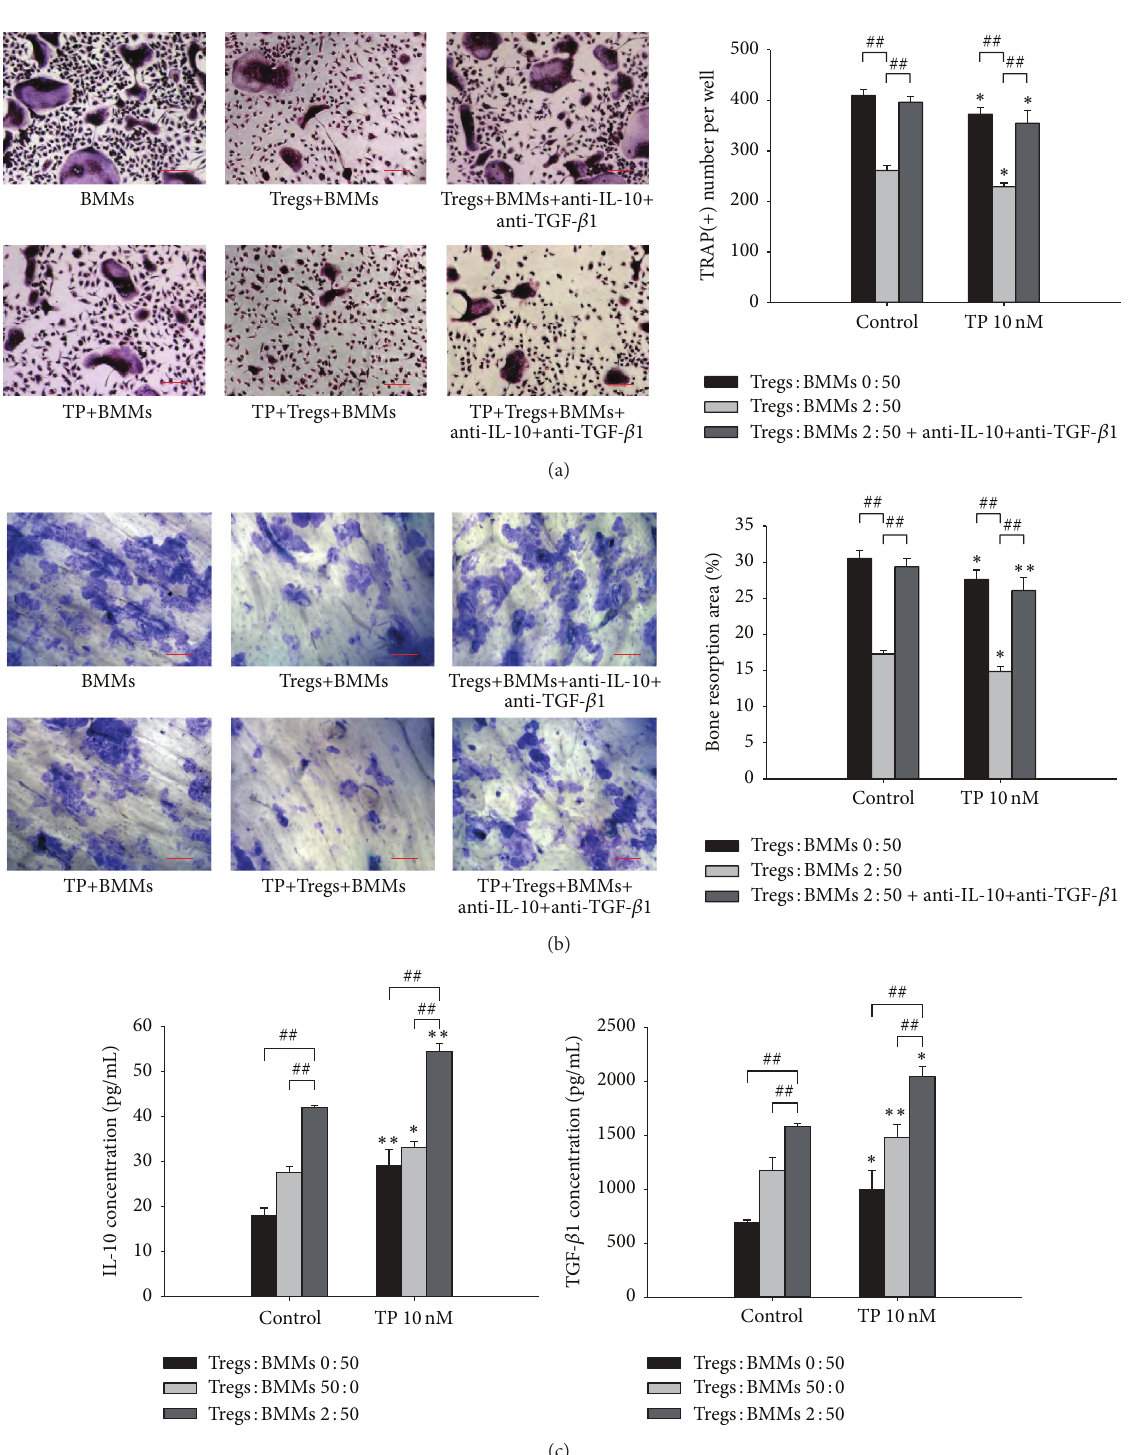
Figure 3: The effect of the indicated concentrations of triptolide on cocultures of Tregs and BMMs. (a) The cells were stained with TRAP, and TRAP-positive cells containing 3 or more nuclei were scored. Scale bars = 100 𝜇 m. (b) The area of the bone resorption pits of the osteoclasts was visualized by staining with toluidine blue and measured using an image analysis program. Scale bars = 100 𝜇 m. (c) The levels of IL-10 and TGF- 𝛽 1 in the coculture supernatants were measured by ELISA. ∗ 𝑃 < 0.05 and ∗∗ 𝑃 < 0.01 compared with the control group (TP 0nM group). # 𝑃 < 0.05 and ## 𝑃 < 0.01 compared with the coculture